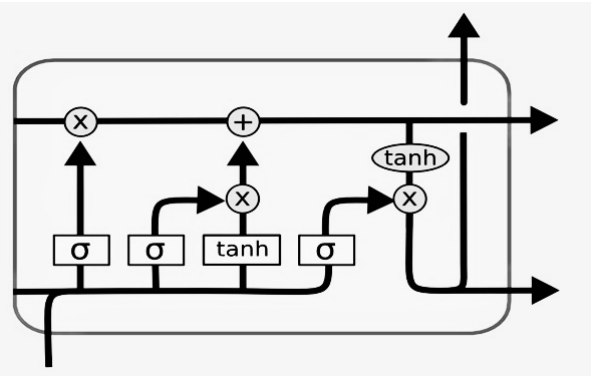
Figure 4. long-short-term memory layer.